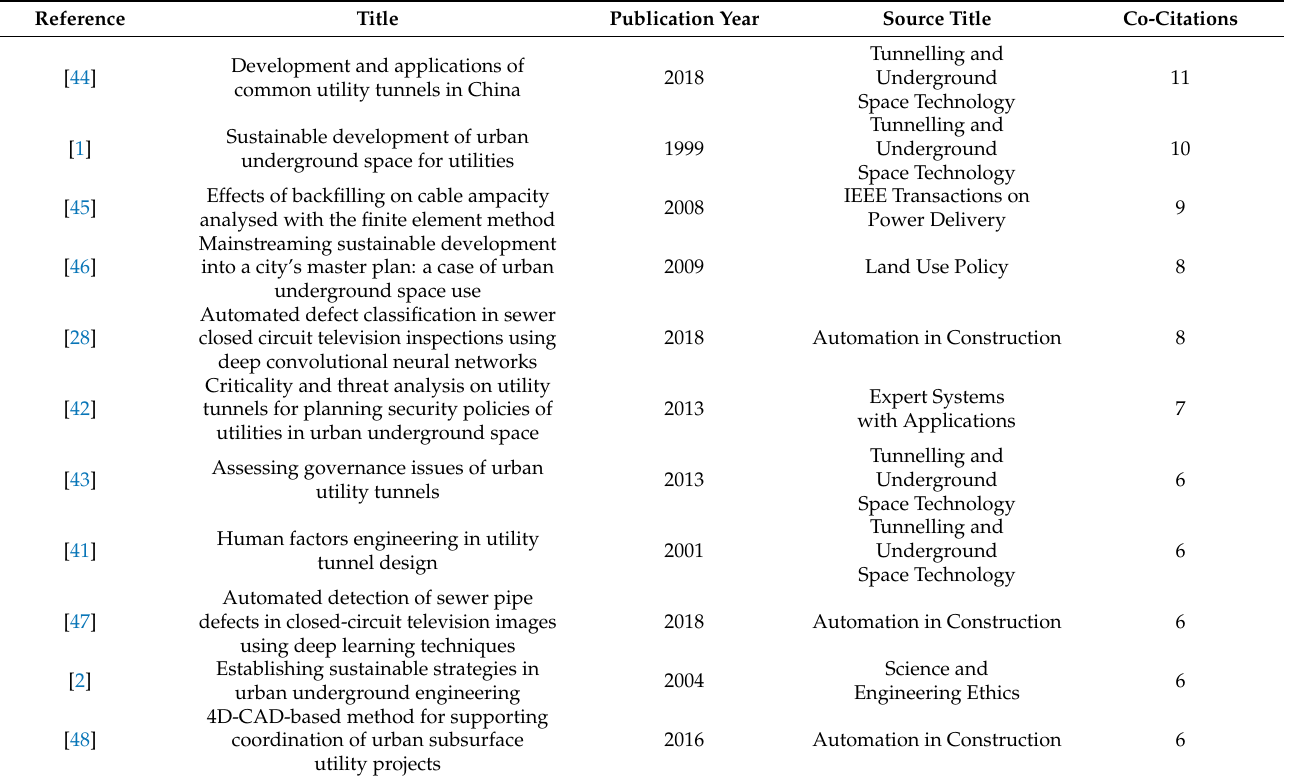
Table 3. The most co-cited papers in the UI research